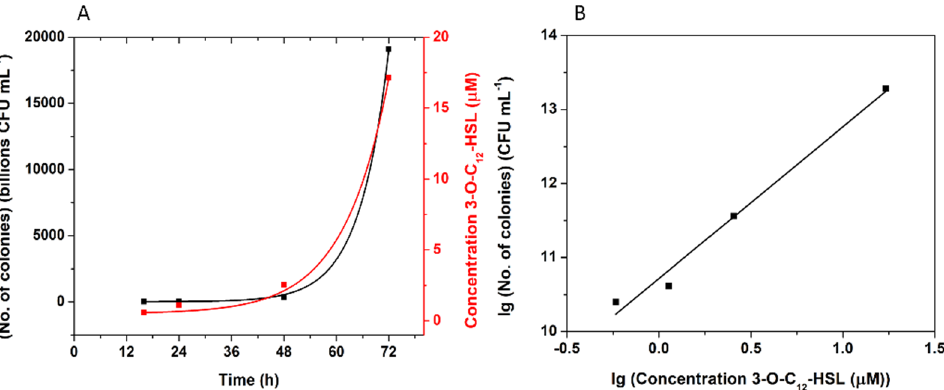
Figure 12. Correlation between the concentrations of 3-O-C 12 -HSL, determined with the sensors and the number of bacterial cells of P. aeruginosa ATCC 27853: The number of bacterial cells ( black , left O–Y axis) and the concentration of 3-O-C 12 -HSL determined with the sensor ( red , right O–Y axis) as a function of time (h) ( A ), and ( B ) linear fitting of the correlation between the lg of the number of bacterial cells and the lg of the concentration of 3-O-C 12 -HSL.